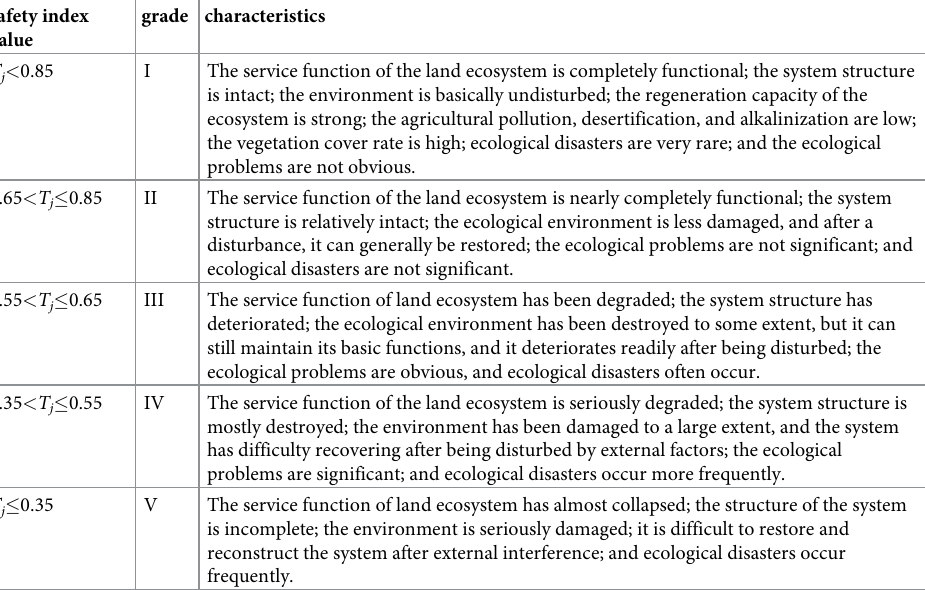
Table 12. Description of the land-based ecological security index value ranges and system